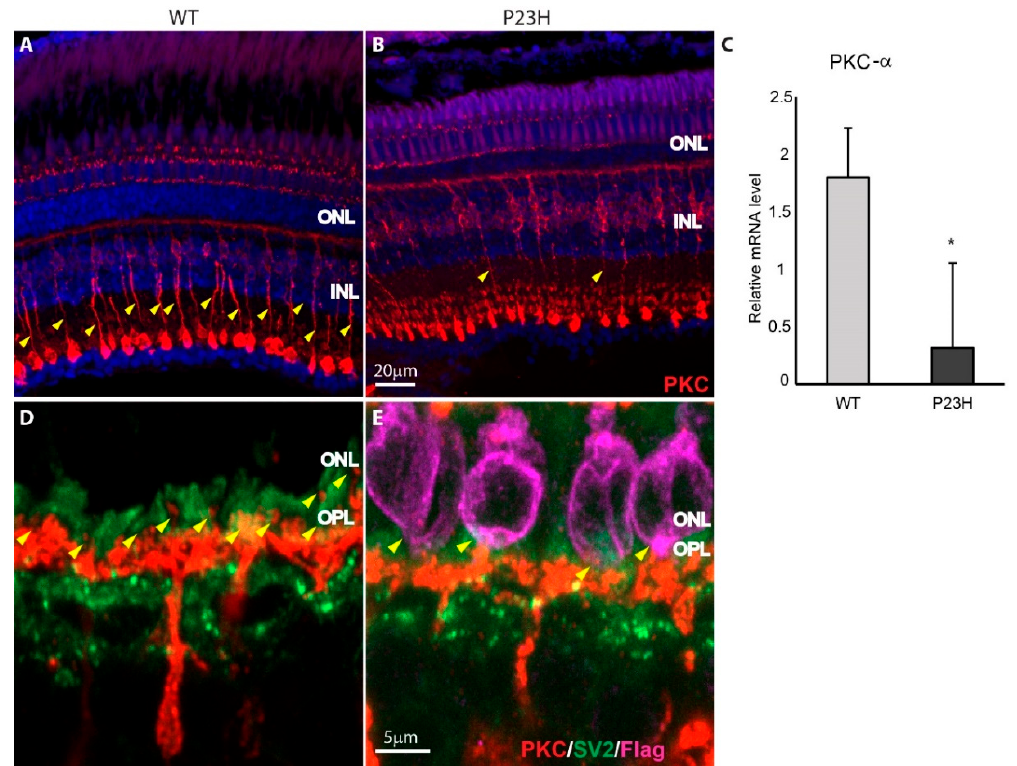
Figure 7. Bipolar cell synapses in P23H transgenic retina. ( A , B ) Immunolabeling for PKC- α (red) shows that rod bipolar cells are morphologically similar, but PKC- α labeling is less intense in the P23H transgenic (B) compared to WT (A). Yellow arrowheads indicate the bipolar cell axons. ( C ) Relative mRNA level of PKC- α is higher in the WT compared to the P23H ( n = 3 fish per genotype; error bars are ± SD; * p < 0.05). ( D , E ) Enlarged images show the synaptic contacts made by PKC-labeled bipolar cells with rod and cone photoreceptor terminals labeled for SV2 (green). Fine synaptic contacts onto rods are shown with yellow arrowheads. Bipolar cells appear to contact some of the rods expressing the P23H rhodopsin (magenta) ( E ). ONL: outer nuclear layer; INL: inner nuclear layer; OPL: outer plexiform